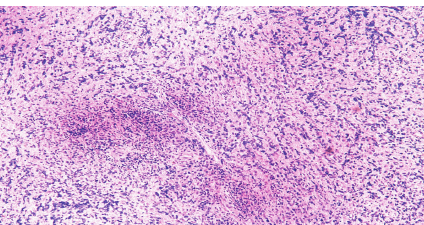
Figure 3: Large transformed lymphocytes are identified (low power). They are uniformly CD20+. Having in mind that there is a background sclerosis, the diagnosis is mediastinal large B- cell lymphoma with sclerosis. If the disease is localized to the mediastinum, the prognosis of this lymphoma is excellent. Stains used in this study: CD20, CD3, CD30, and CD10.